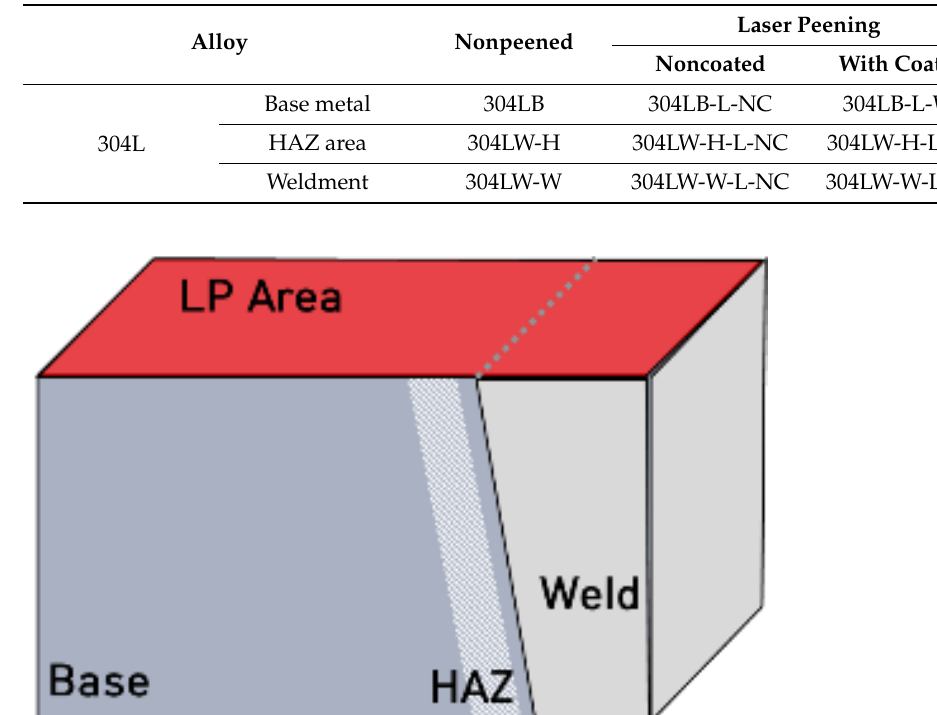
Table 3. Designation of the experimental specimen.